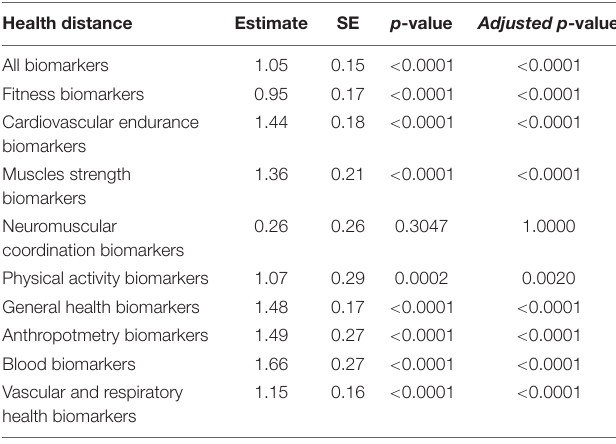
TABLE 4 | Estimates of group differences in Health Distance for Healthy (healthy participants aged ≥ 40 years) and Heart Failure (patients with heart failure). Estimates and standard errors are for age 40